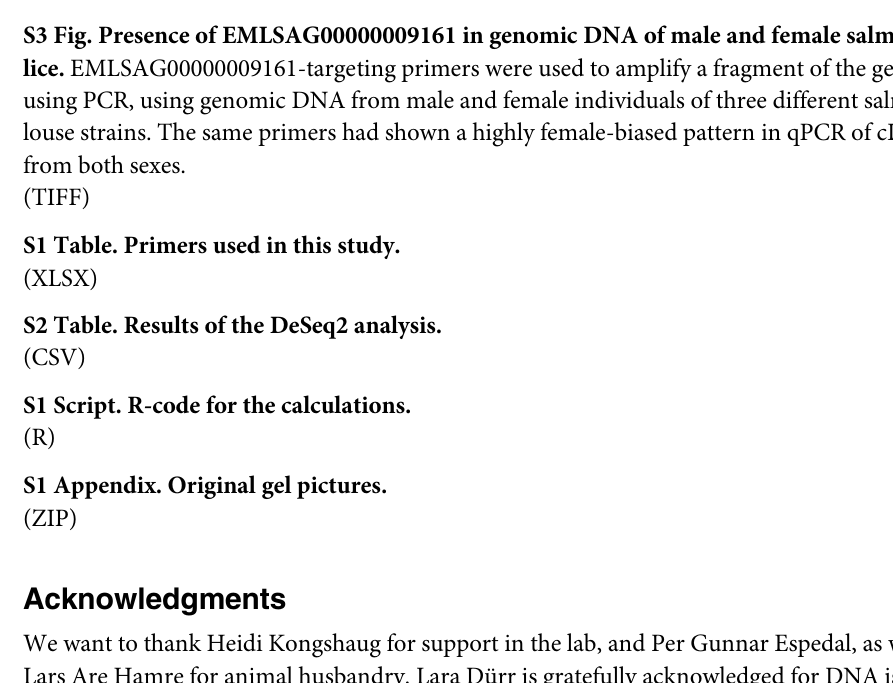
S1 Table. Primers used in this study. S2 Table. Results of the DeSeq2